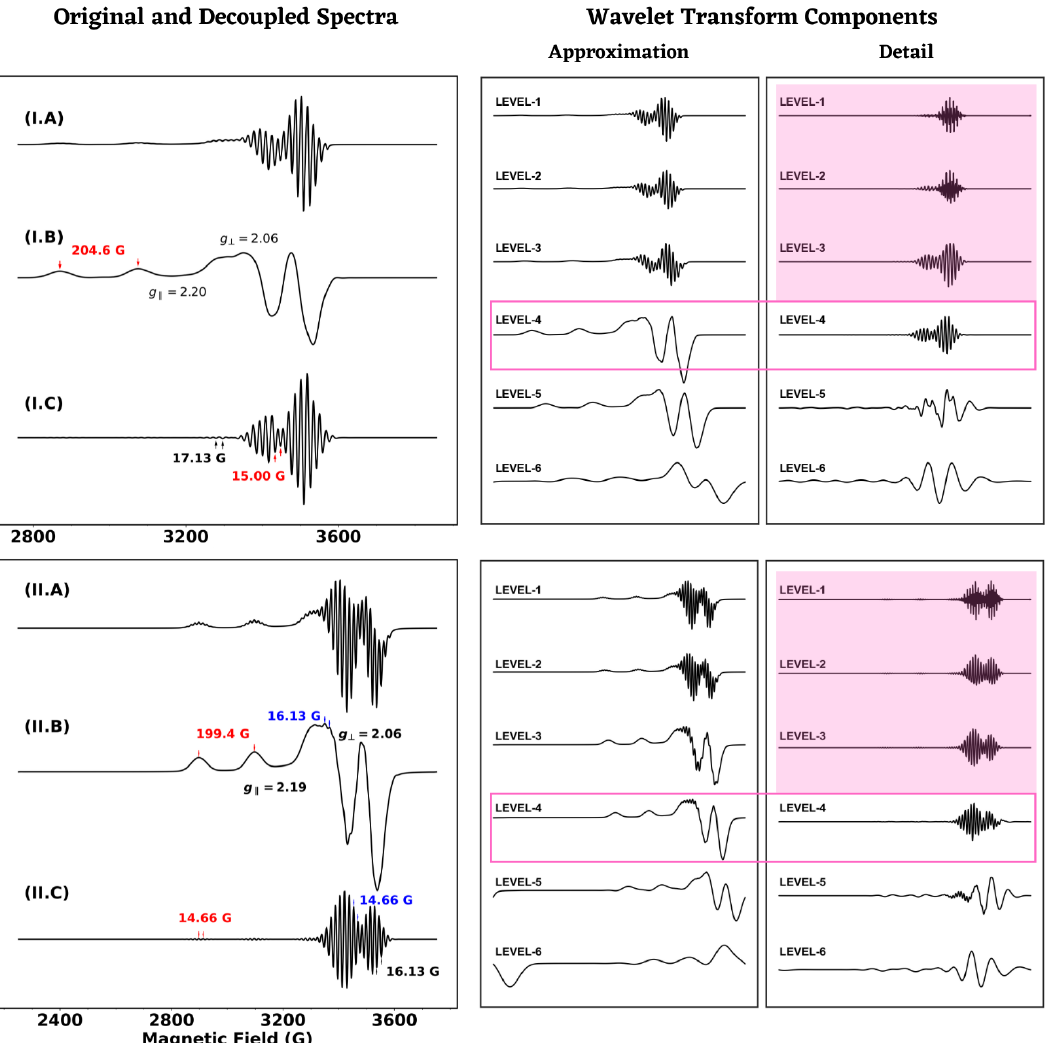
Figure 4. Original X-band cw-ESR spectra ( left panel ) and the corresponding decoupled components ( right panel ) for M-I (I) and M-II (II) are shown in the left panel, while the right panel shows wavelet transform components at different levels. The Detail components between level-1 and -3 were removed from the spectra sequentially (magenta background) and the resulting components at level-4 (magenta box) were used for both of the cases to perform the pseudo-decoupling. The values of g (cid:107) and g ⊥ were resolved along with the 14 N super-hyperfine coupling. Pairs of colored arrows are used to indicate hyperfine and super-hyperfine